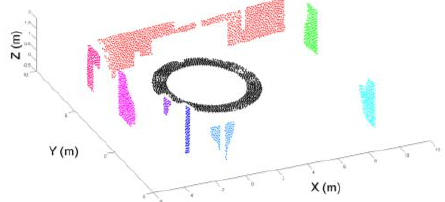
Figure 14: Sample of planar features extracted from the GS200 point cloud for use in the plane-based self-calibration. Table 4: Statistics of plane-based self-calibration of GS200